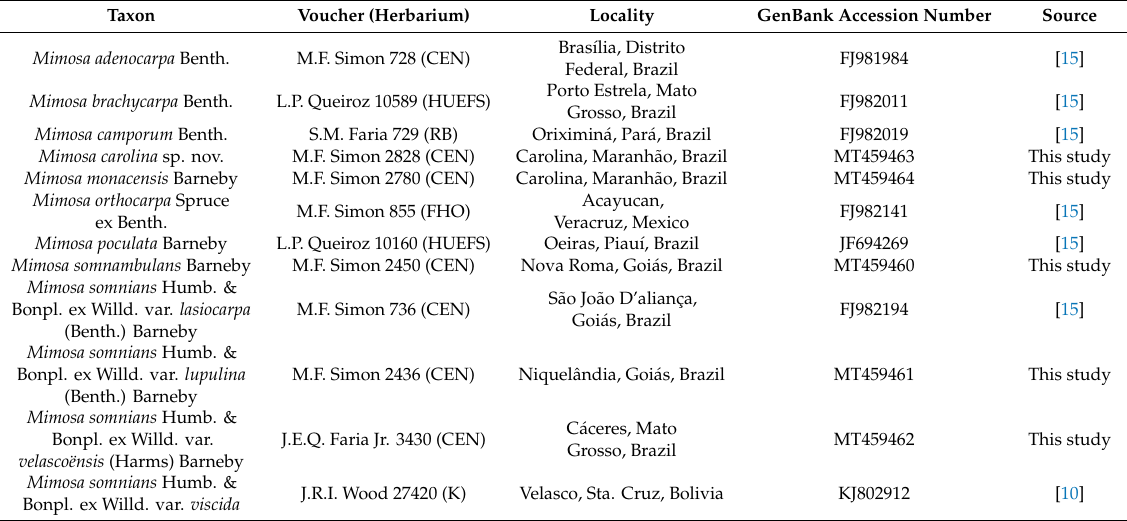
Table 2. Voucher information, locality, and GenBank accession numbers of taxa used in the phylogenetic